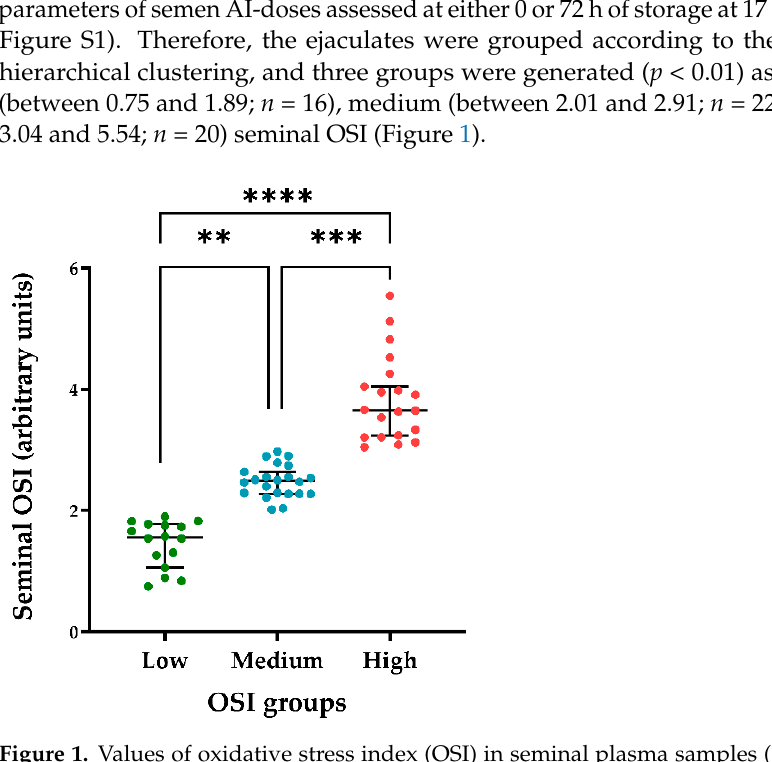
Figure 1. Values of oxidative stress index (OSI) in seminal plasma samples ( n = 58) from porcine entire ejaculates ( n = 58; one per boar). The ejaculates were clustered according to their seminal OSI values (hierarchical clustering, p < 0.01) as having low (between 0.75 and 1.89; n = 16), medium (between 2.01 and 2.91; n = 22) or high (between 3.04 and 5.54; n = 20) OSI values. The line indicates the median, the whiskers extend to the 5th and 95th percentiles, and dots represent the seminal OSI values. **** p < 0.00001; *** p < 0.0001; ** p <